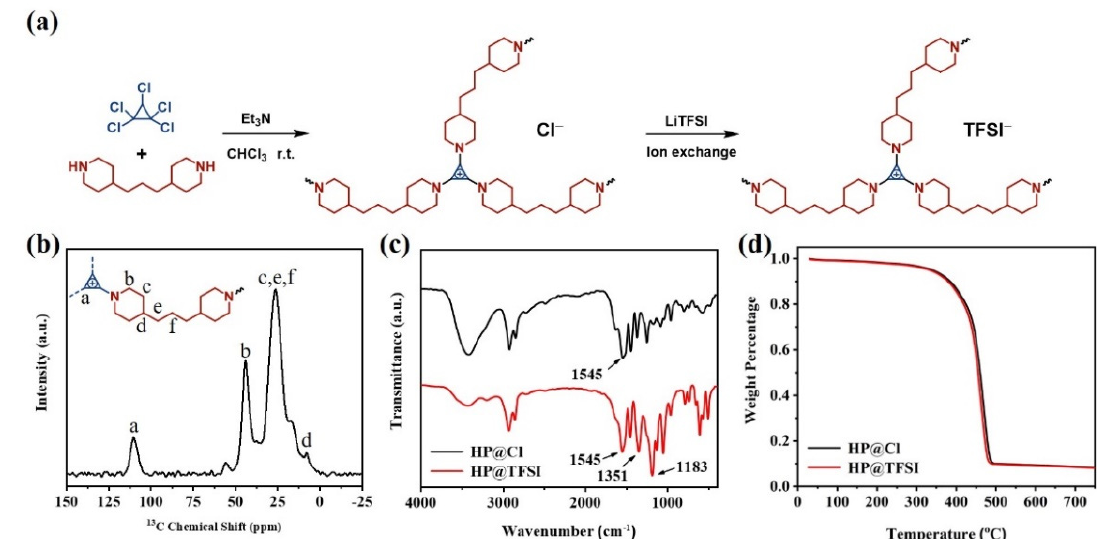
Figure 1. ( a ) Preparation of HP@X; ( b ) Solid-state NMR of HP@Cl; ( c ) FT-IR spectra of HP@Cl and HP@TFSI; ( d ) TGA curves of HP@Cl and HP@TFSI.